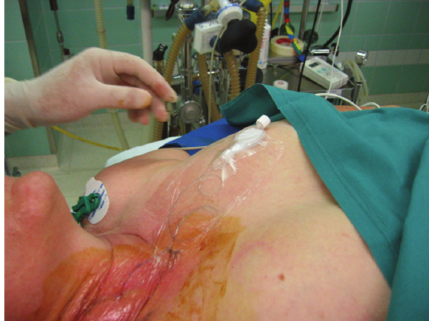
Figure 2: Sterile catheter dressing after catheter tunneling.